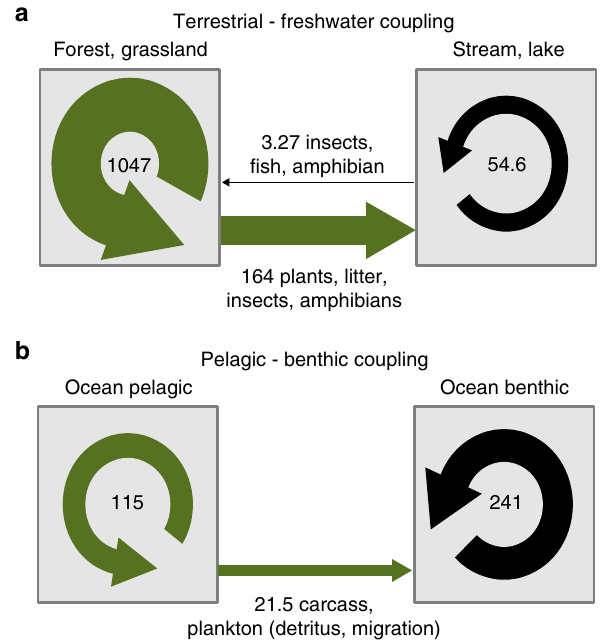
Fig. 5 Well-documented natural meta-ecosystems. a Terrestrial – freshwater and b pelagic – benthic ecosystem spatial couplings. Round and horizontal arrows represent gross primary production (GPP) and cross-ecosystem fl ows, respectively. Numbers are median values for GPP and sum of median values of cross-ecosystem fl ows of each different origin (primary producer, invertebrate, vertebrate, and particulate and dissolved organic carbon), both expressed in gC m − 2 year − 1 . Width of arrows is proportional to these values based on double squared root transformation. Inter-quartile ranges [IQR] for GPP: terrestrial [589 – 1497], freshwater [15.3 – 160.5],